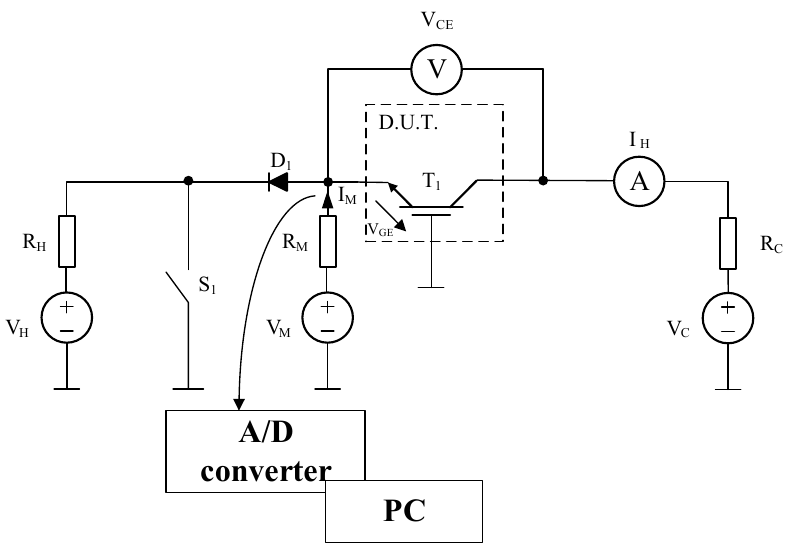
Figure 4. Transient thermal impedance Z th ( t ) measurement set-up scheme. In the measuring set-up, the thermal impedance Z th ( t ) was determined in three steps.